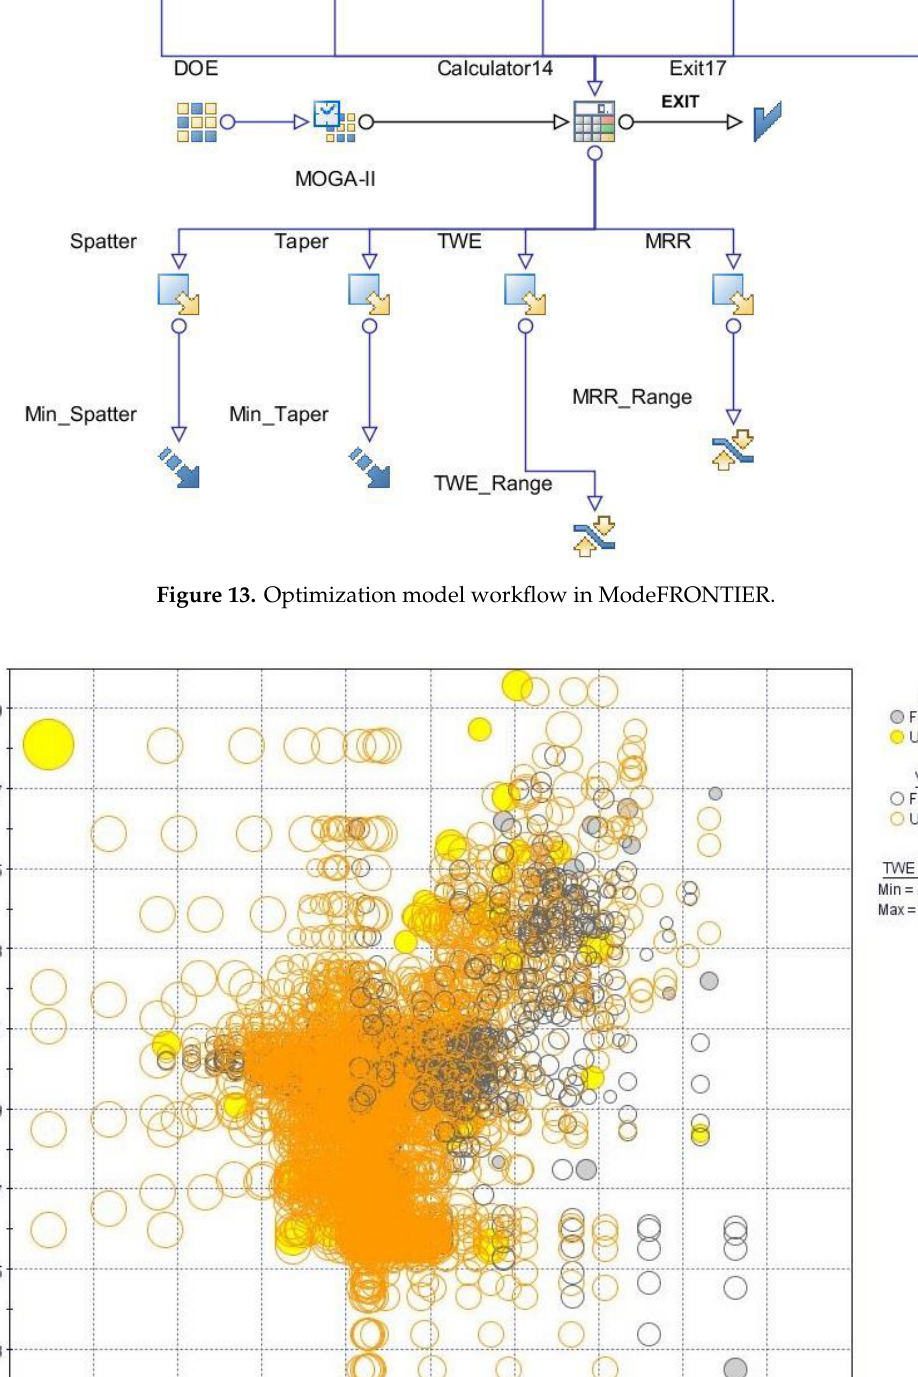
Table 3. Objective functions and constraints for the optimization.